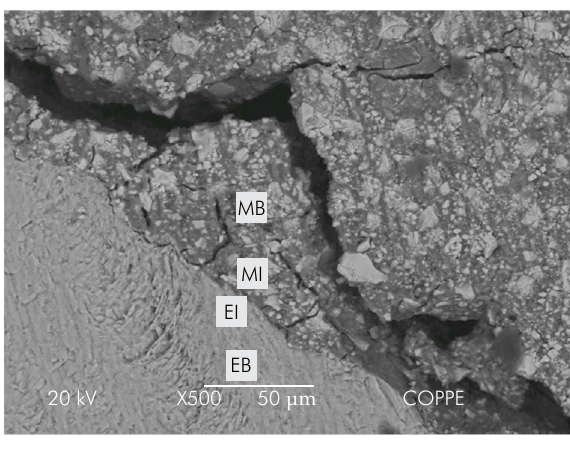
Figure 1. Fuji IX™ group SEM image with representative EDX points: (MB) material bulk; (MI) material interface; (EI) enamel interface; (EB) enamel